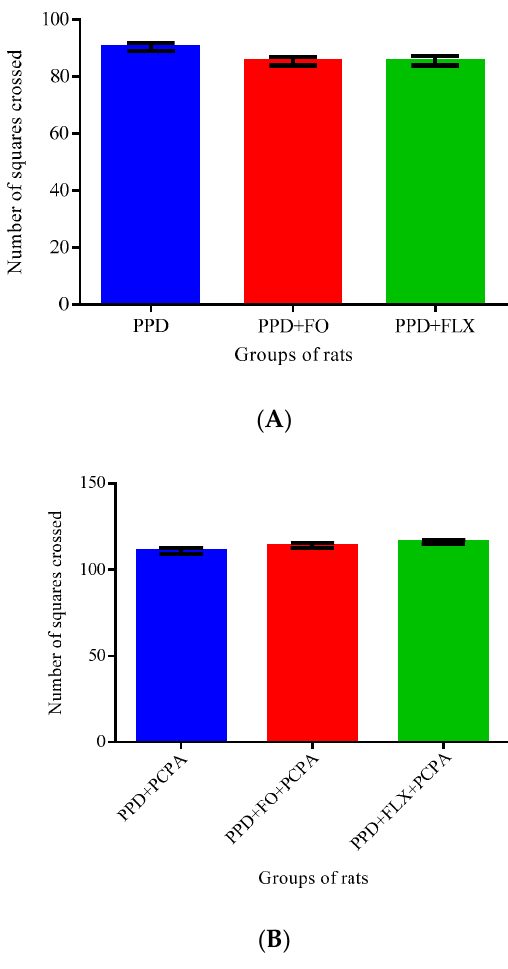
Effect of PCPA on FO and FLX on open field test (OFT) in PPD-like rats. ( A )—Protocol 1. ( B )—Protocol 2. (PPD—postpartum depression-like, FO—fish oil, FLX—fluoxetine, PCPA—p- cholorophenylalanine).